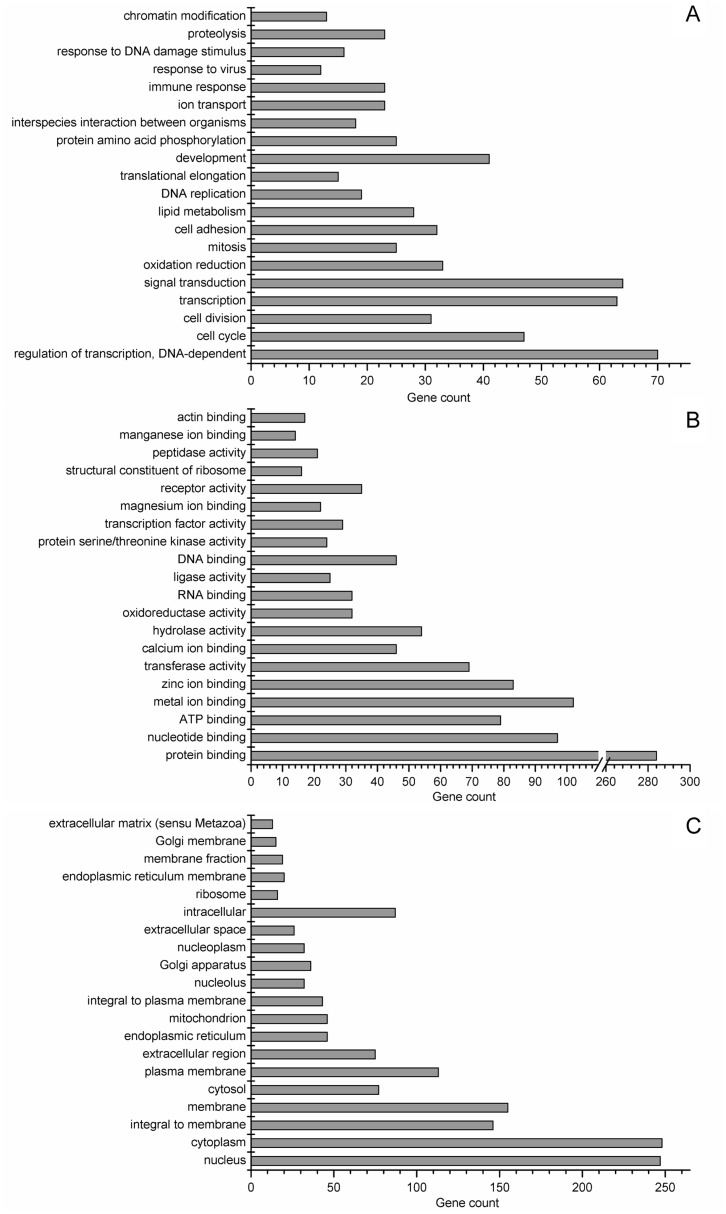
Gene ontology analysis of DEGs with FDR <10%.(A) biological process; (B) molecular function; and (C) cellular component. The GO terms were sorted by the enrichment p-value calculated by MAS 3.0, in an ascending order from bottom to top.